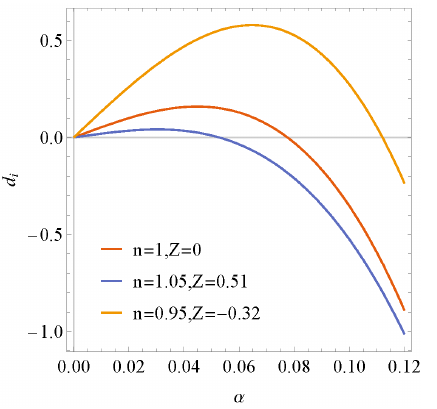
Figure 3. Linear amplitude growth rate of disturbed waves for various n and Z at Re = 10.